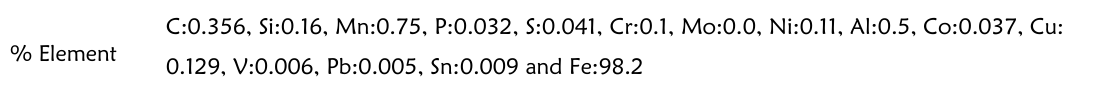
Table 1: Chemical composition of the Medium Carbon Steel